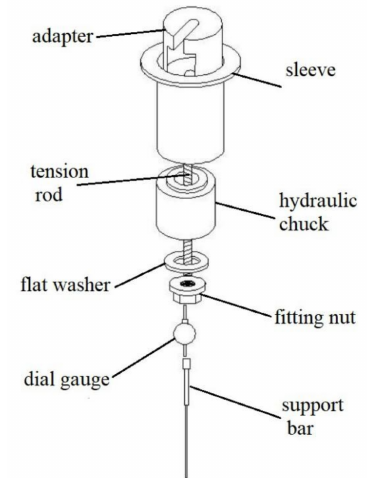
Figure 13. Pull-out test in the 1301 haulage roadway.